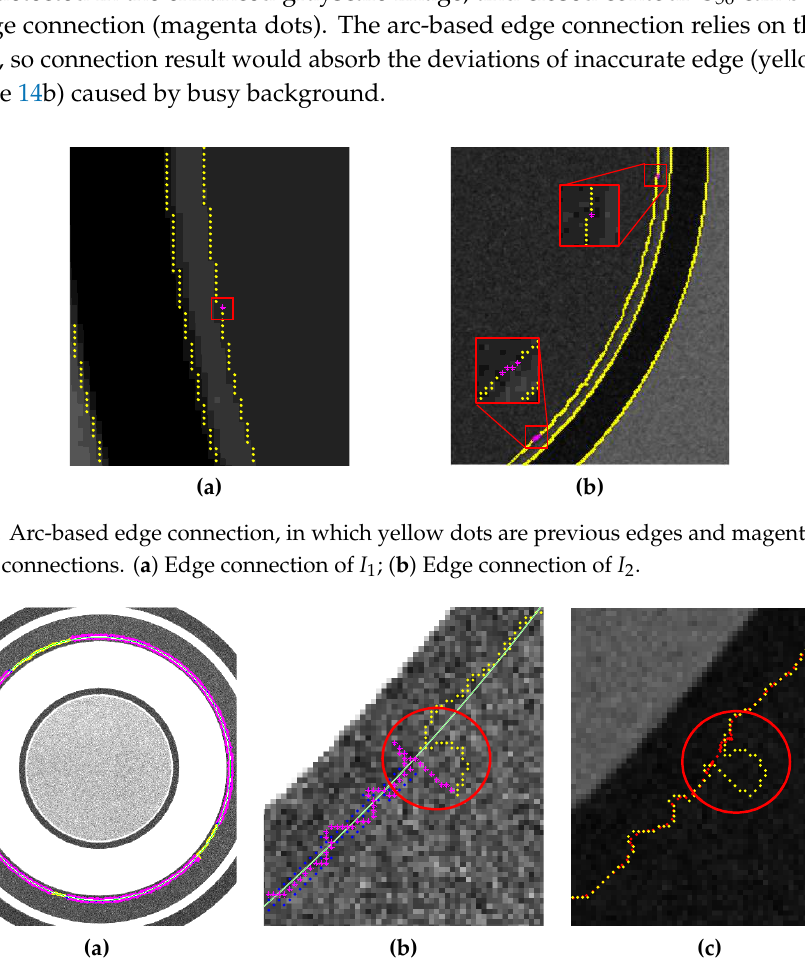
Figure 14. Edge 56 connection and C 56 refinement. ( a ) Arc-based connection of Edge 56 with the enhanced Figure 14. (cid:1831)(cid:1856)(cid:1859)(cid:1857) (cid:2873)(cid:2874) connection and (cid:1829) (cid:2873)(cid:2874) refinement. (a) Arc-based connection of (cid:1831)(cid:1856)(cid:1859)(cid:1857) (cid:2873)(cid:2874) with the Figure 14. 𝐸𝑑𝑔𝑒 56 connection and 𝐶 56 refinement. (a) ⁡ Arc-based connection of 𝐸𝑑𝑔𝑒 56 with the grayscale image as base map, in which yellow dots are Edge 56 , blue dots denote search range and enhanced grayscale image as base map, in which yellow dots are (cid:1831)(cid:1856)(cid:1859)(cid:1857) (cid:2873)(cid:2874) , blue dots denote search enhanced grayscale image ⁡ as base map, in which yellow dots are 𝐸𝑑𝑔𝑒 56 , blue dots denote search magenta asterisks are accepted search points; ( b ) Partial enlargement of ( a ); ( c ) LTBC to a mutation in range and magenta asterisks are accepted search points; (b) Partial enlargement of (a); (c) LTBC to a range and magenta asterisks are accepted search points; (b) Partial enlargement of (a); (c) LTBC to a edge connection result, in which yellow dots are initial closed C 56 and red dots are refined results after mutation in edge connection result, in which yellow dots are initial closed (cid:1829) (cid:2873)(cid:2874) and red dots are mutation in edge connection result, in which yellow dots are initial closed 𝐶 56 and red dots are corrections to detected refined results after corrections to detected mutation. refined results after corrections to detected mutation.